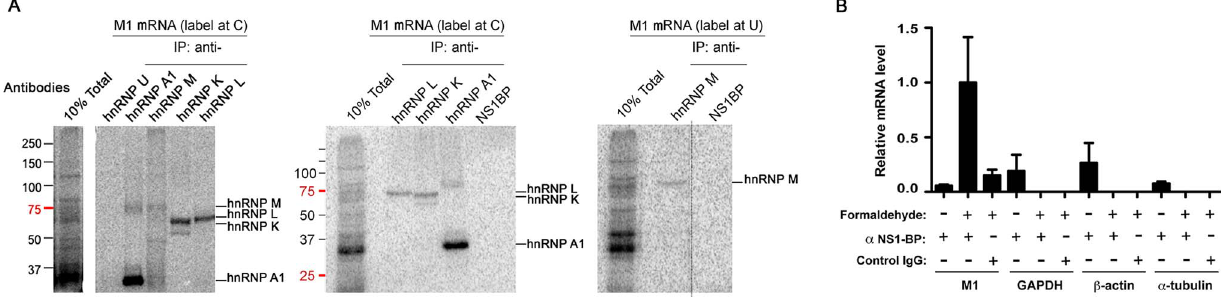
Figure 3. NS1-BP interacts with hnRNPs that directly bind M1 mRNA. (A) The entire M1 RNA was radiolabeled uniformly at either C (left) or U (right) residues, incubated with nuclear extract under splicing conditions, crosslinked with 254 nm light and digested with RNase. The reaction was then either resolved by SDS-PAGE (10% Total) or incubated in separate reactions with the antibodies indicated (IP: anti-). Immunoprecipitated proteins were resolved by SDS-PAGE. Position of molecular weight markers are also shown. Vertical dotted line shows that the samples were loaded in the same gel but not next to each other. Figure S4 shows immunoblot analysis of nuclear extract with antibodies against NS1-BP and hnRNP U, which did not directly bind M1 mRNA but are present in the extract. (B) A549 cells were infected with A/WSN/33 at MOI 5 for 5 h and were then cross- linked with 0.3% formaldehyde. Cells were lysed with RIPA buffer, and the lysates were immunoprecipitated with control IgG or NS1-BP antibodies. After a series of washes, the cross-link was reversed, and associated RNAs were isolated. Real-time quantitative RT-PCR was used to measure M1 mRNA. Housekeeping genes (GAPDH, b -actin, and a -tubulin) were included to test the specificity of the assay. Data was normalized to the viral M segment. The graph displays the mean 6 SEM (n=3). Comparison between cross-linked samples shows significant (p , 0.05) differences between association of NS1-BP with M1 mRNA and the lack of association of NS1-BP with the 3 host mRNAs tested.